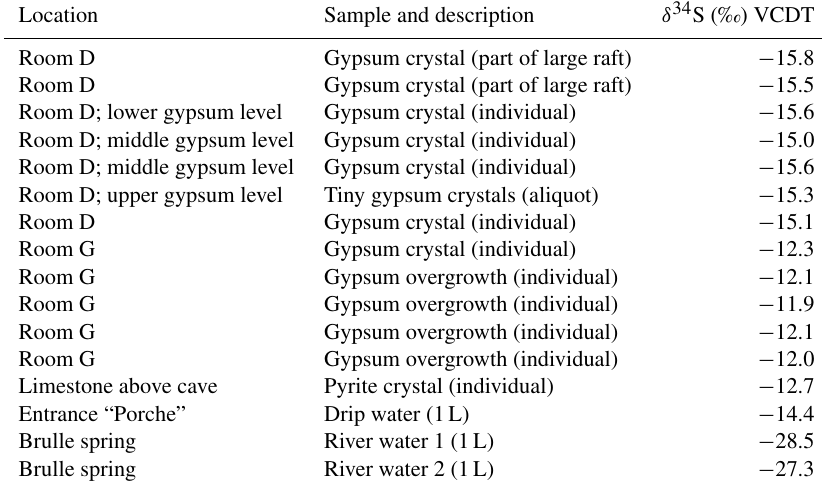
Table 2. Sulfur isotope values of gypsum, water, and pyrite from